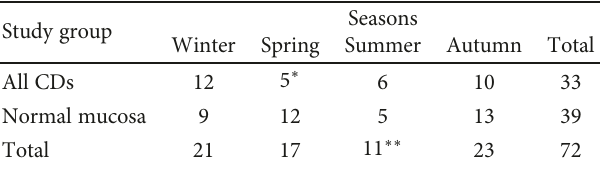
Table 2: Seasonal distribution of samplings between the study